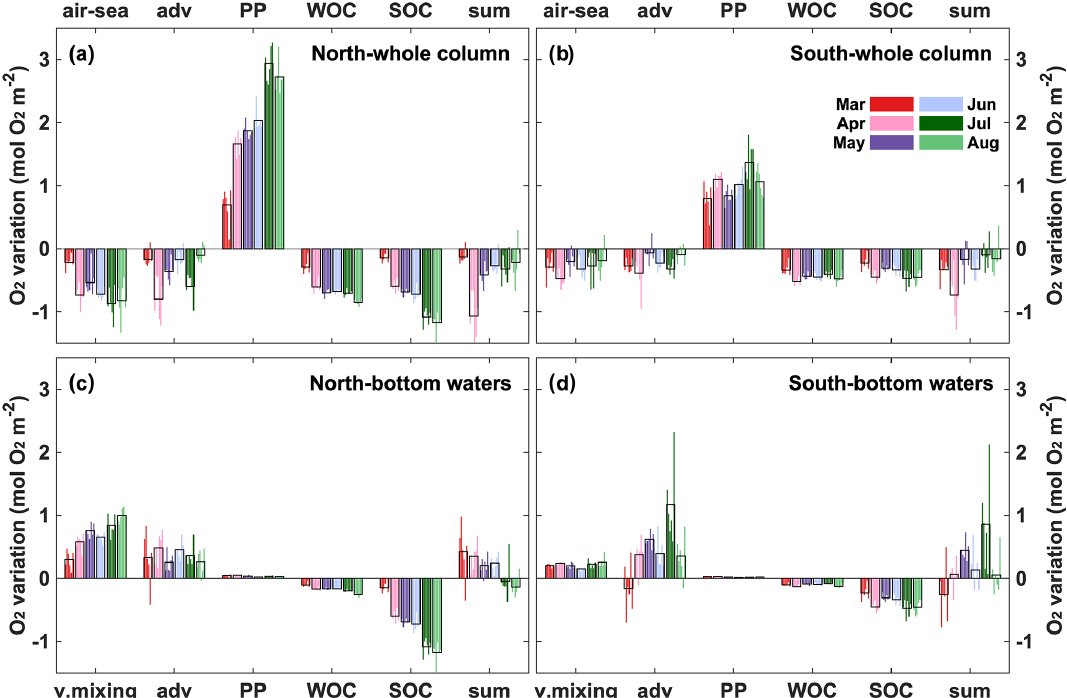
Figure 11. Monthly averaged (2008–2013) oxygen budgets for the whole water column and subsurface water from March to November in the northern and southern hypoxic regions. Adv represents lateral advection and lateral diffusion, which is comparatively small, while v.mixing represents vertical turbulent diffusion, which is only relevant for the subsurface budget. Thin color bars represent individual years, whereas the black bars are the 6-year